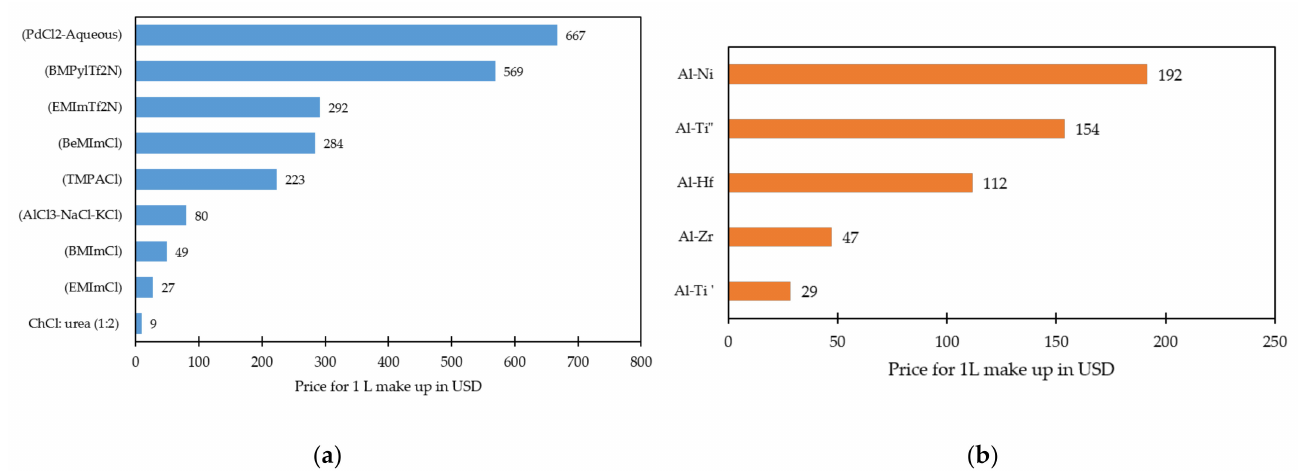
Figure 4. Plots showing the cost comparison of the ( a ) ionic liquid-based systems, an inorganic molten salt system for the electrodeposition of Al [31,72–75], and aqueous electrolyte for the electrodeposition of Pd [48]; ( b ) the ionic liquid-based systems for the electrodeposition of Al-alloys [71], considering the initial make up of 1 L solution. Electrodeposition of Al-Ti alloy from solution containing TiCl 2 and TiCl 4 is represented as Al-Ti’ and Al-Ti”, respectively. Price listings for the ionic liquid electrolytes refer to the time period from January 2021 till